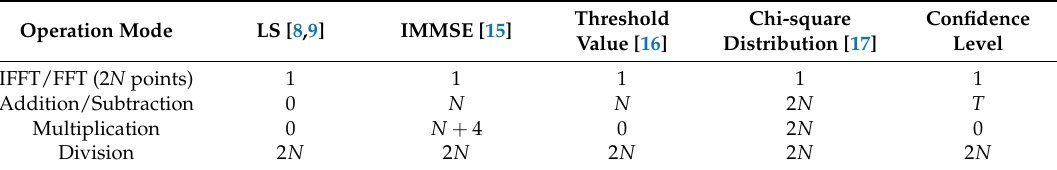
Table 4. Computational complexity comparison of channel estimation methods. LS: least square; IFFT: inverse fast Fourier transform; FFT: fast Fourier